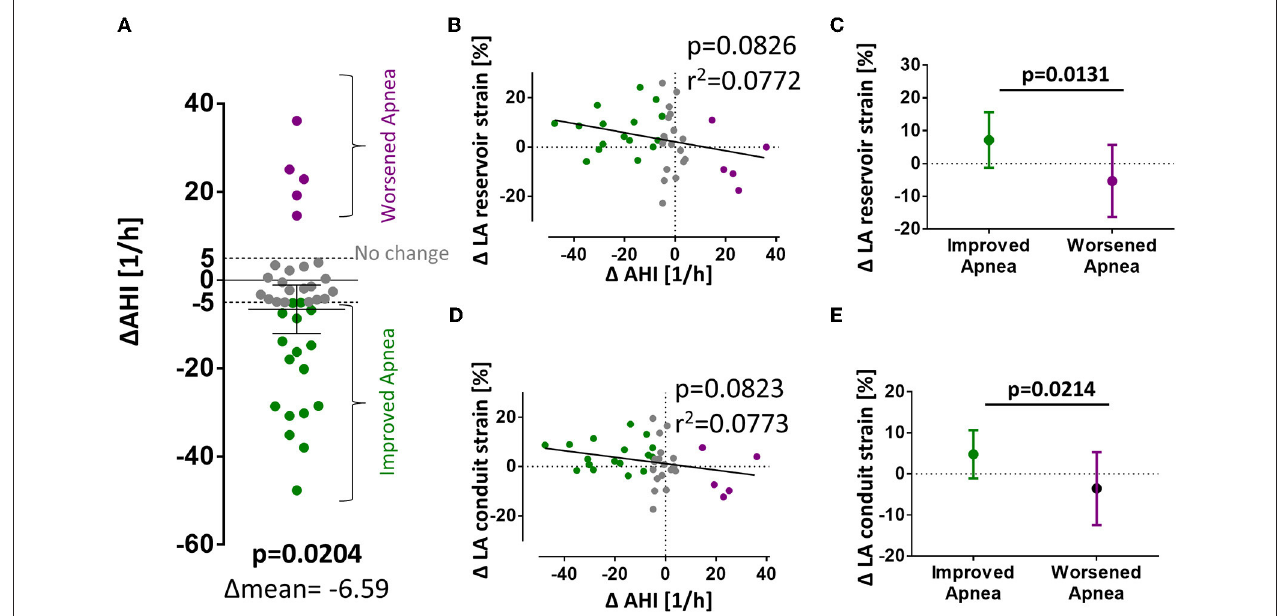
FIGURE 4 | Changes in AHI and LA strain from baseline to follow-up. (A) Significant reduction of AHI between baseline and follow-up. (B–E) Show differences in strain values from baseline to follow-up organized vertically for LA ε s , ε e , and ε a and horizontally for mean difference; correlation of differences in AHI and strain; and strain values dichotomized for reduction or increase in AHI ( > ± 5/h, respectively). p -values for total mean difference are calculated with the one-sided Student’s t -test. Comparison between dichotomized groups were calculated with the two-sided Student’s t -test. Bold p -values signify statistical significance p < 0.05.